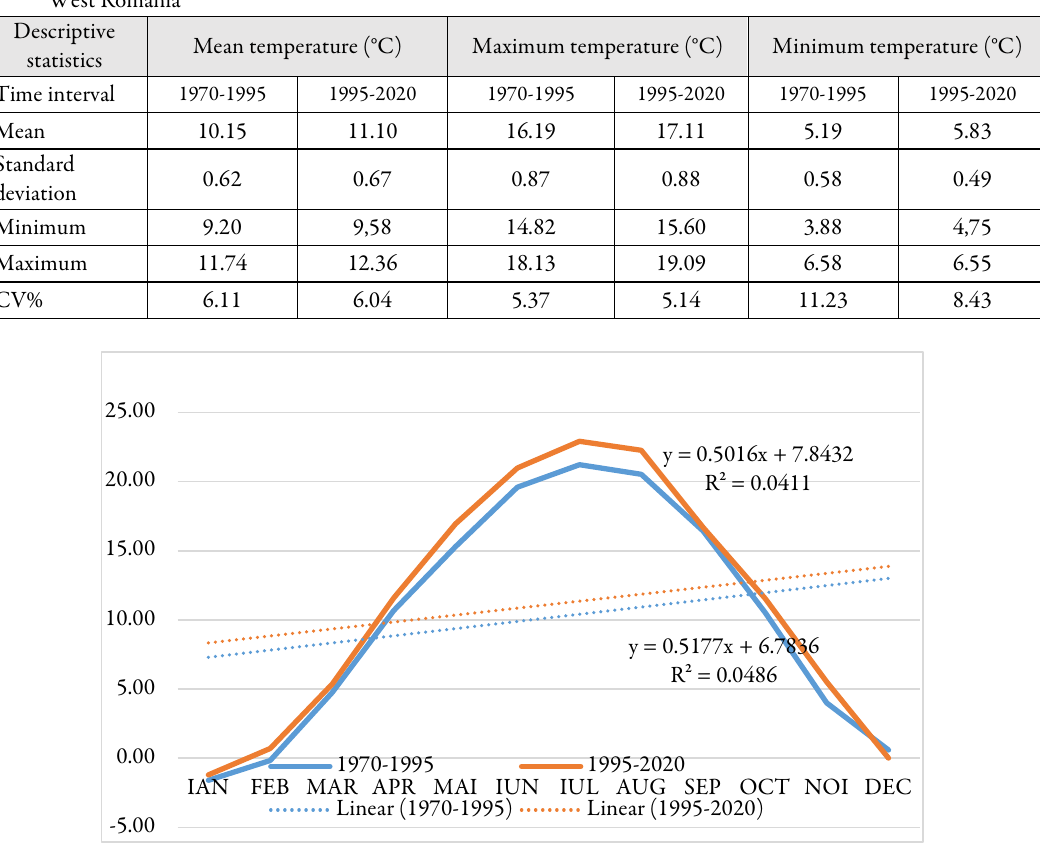
Figure 1. Evolution of monthly average temperatures over the analysed time